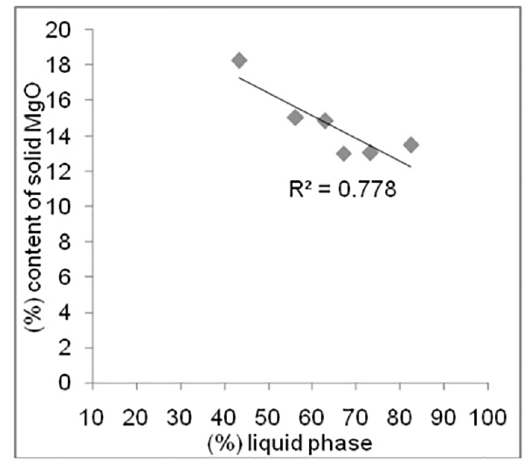
Figure 8. Relation between MgO content and desulfurization yield. Figure 9. Graphics showing the MgO as a function of liquid phase and the desulfurization yield for all marble waste containing